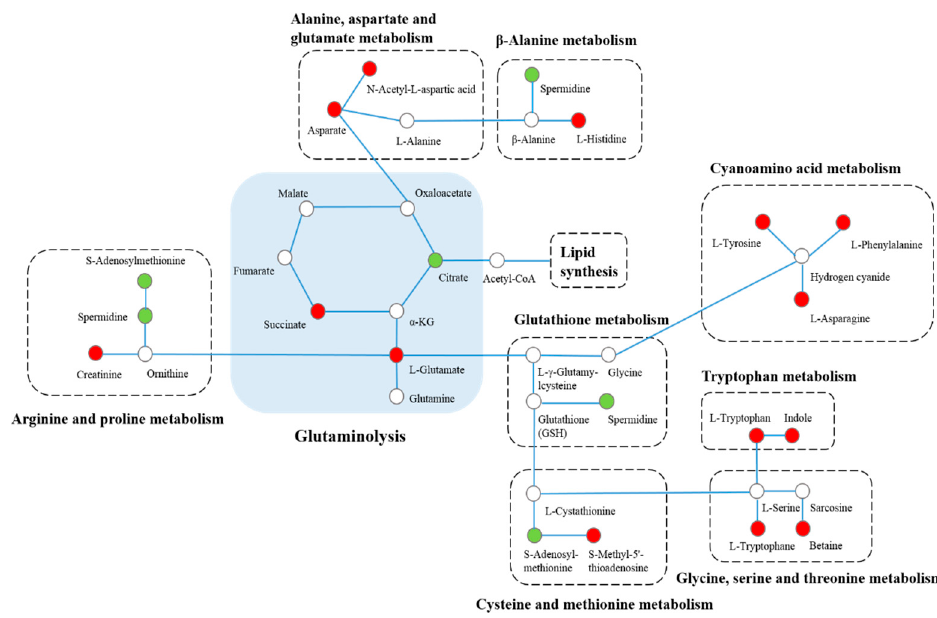
Figure 6. Integrated networks of ISKNV infection outlining biochemical pathways related to amino acid metabolism. Metabolites are represented by circles. Changes in the levels of metabolites (circles) relative to control groups are color-coded to represent up-regulation (red) or down-regulation (green). Colorless boxes indicate that no difference was detected. Metabolomics data were collected from six parallel samples of CPB cells using UHPLC-Q-TOF/MS.